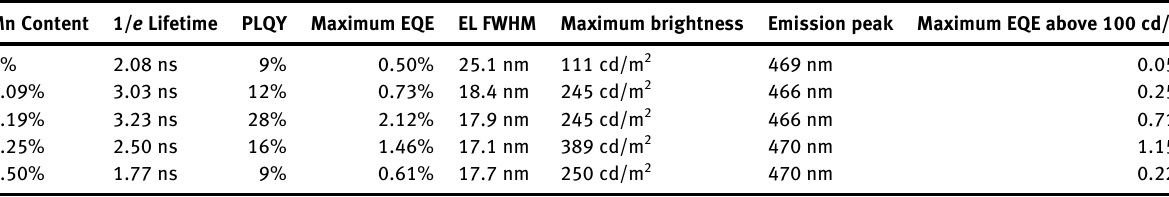
Table  : Material and device parameters of the Mn doped nanocrystals [ 